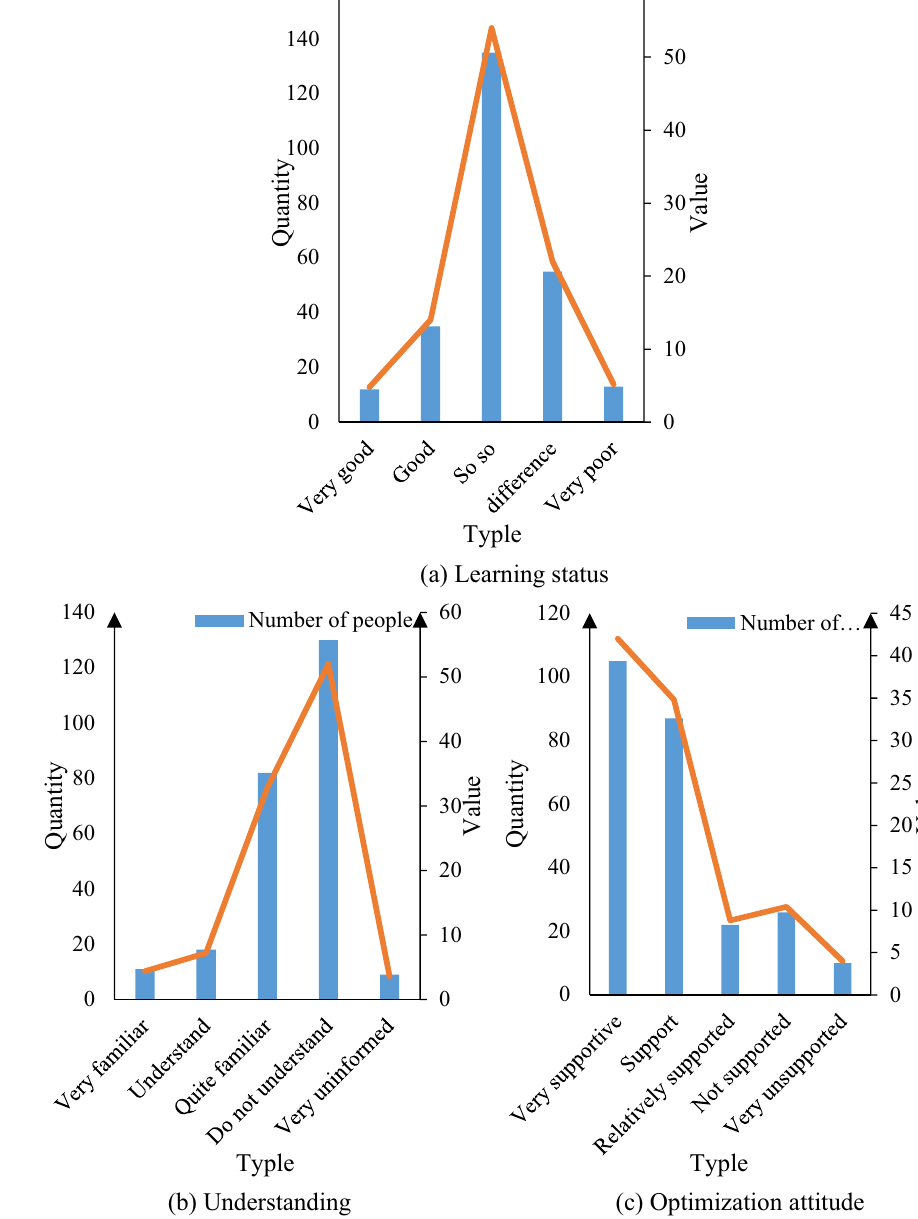
Fig. 3 Students’ learning sta- tus, understanding level and optimization